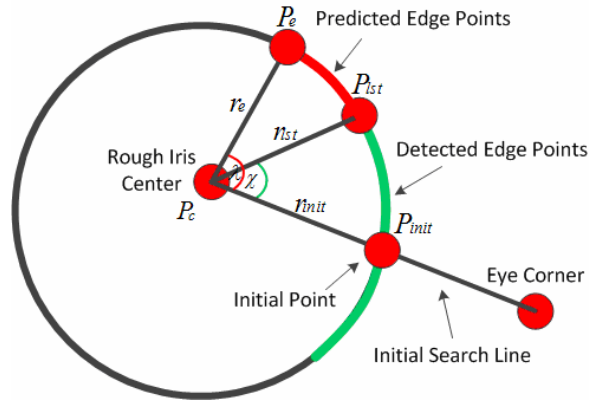
Figure 14: The schematic diagram for Predicted Edge Points Detection Algorithm2.